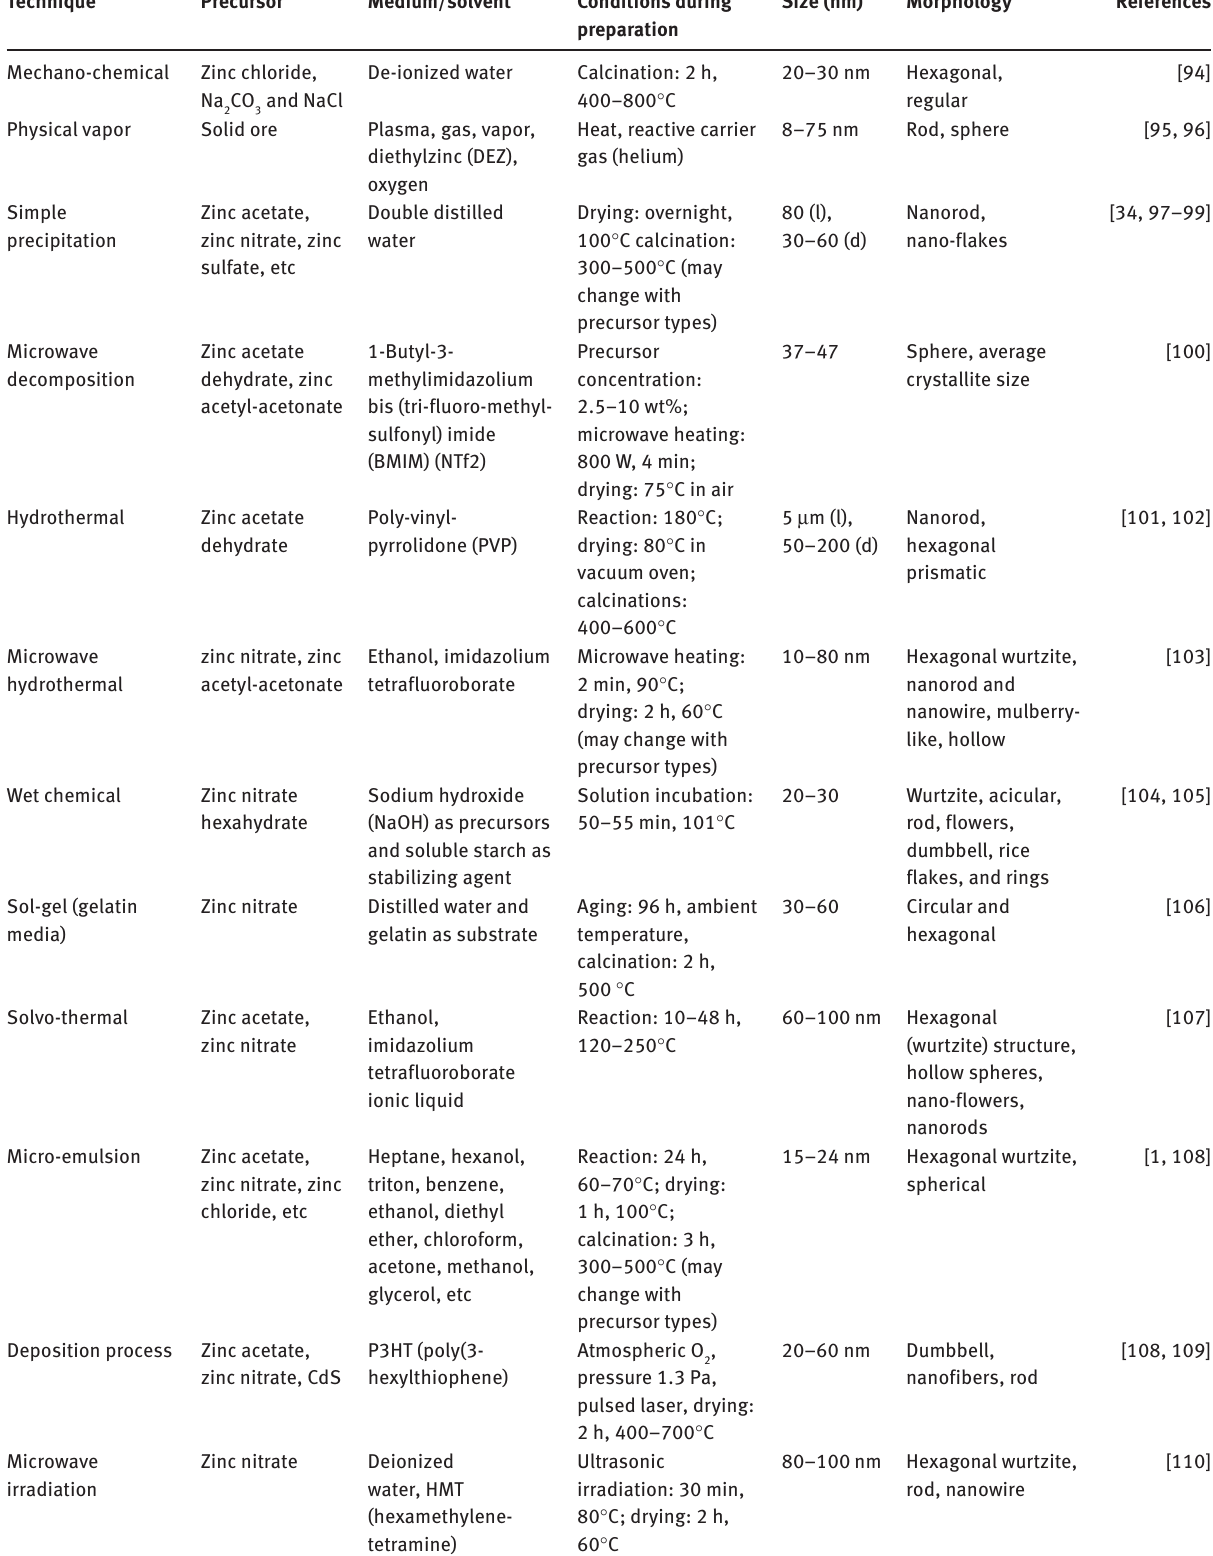
Table 3: Synthesis techniques, precursors, preferred solvents, conditions, and the resultant morphology of ZnO NPs.